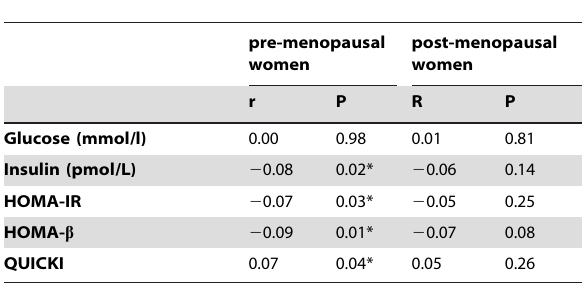
Table 3. Partial correlation of ghrelin with insulin resistance indexes after controlling for age, Percentage of trunk fat and HDL-cholesterol.